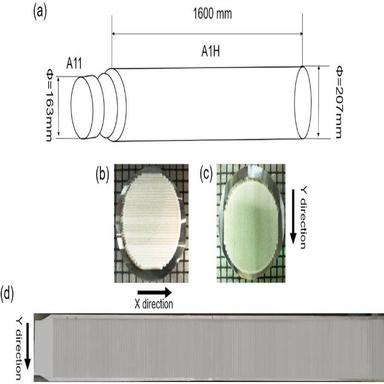
Sample schematic diagram and physical picture (a) Low-alloy steel cast billet schematic diagram (b) physical picture of A11 row mapping by the SMALS (c) physical picture of A11 column mapping by the SMALS (d) physical picture of A1H column mapping by the SMALS.